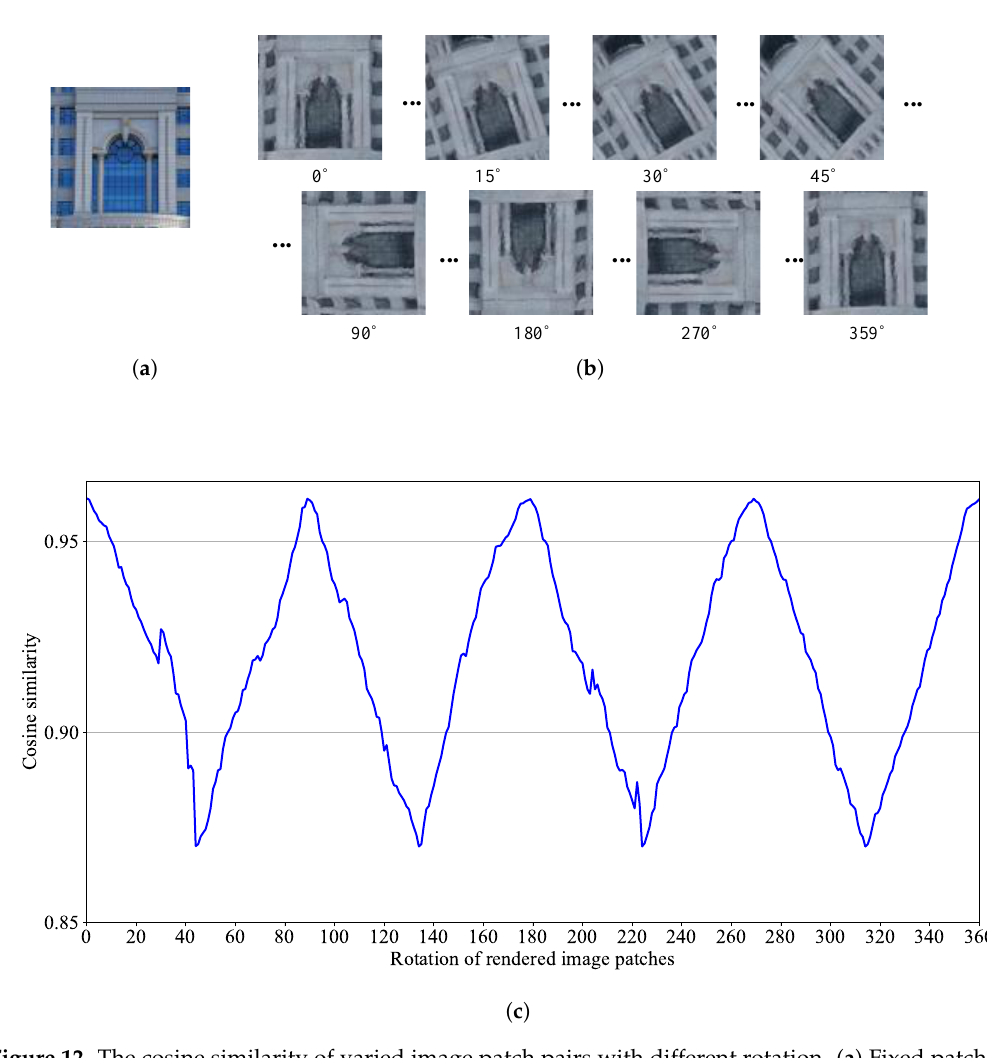
Figure 12. The cosine similarity of varied image patch pairs with different rotation. ( a ) Fixed patch. ( b ) Gradually varied rendered image patches with different rotation. ( c ) The cosine similarity of ( a ) and each patch in ( b